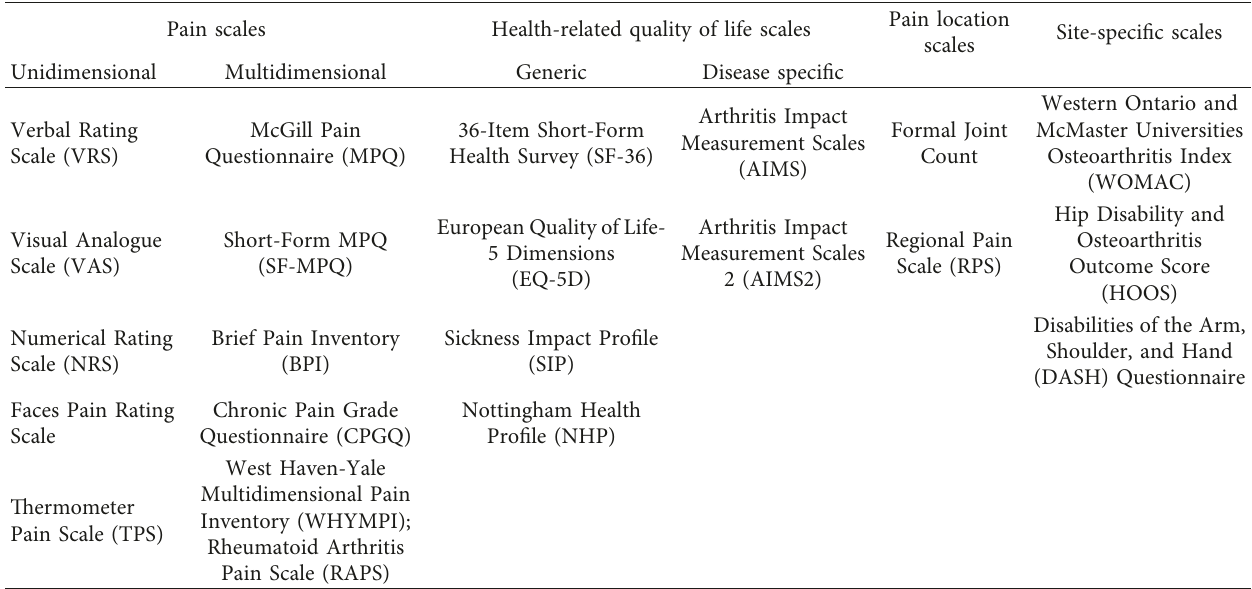
Table 1: Scales to measure all the aspects of pain in patients with rheumatoid